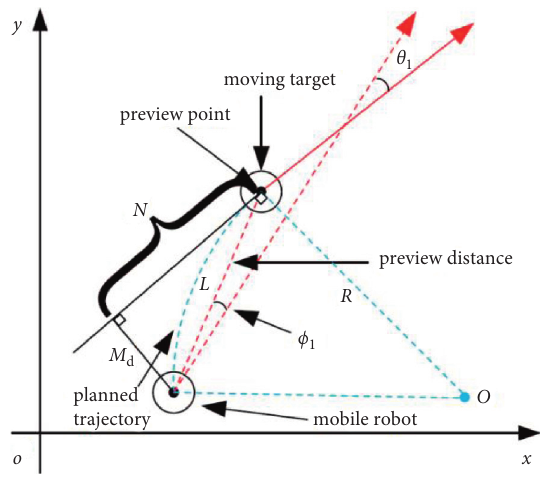
Figure 2: Preview deviation angle